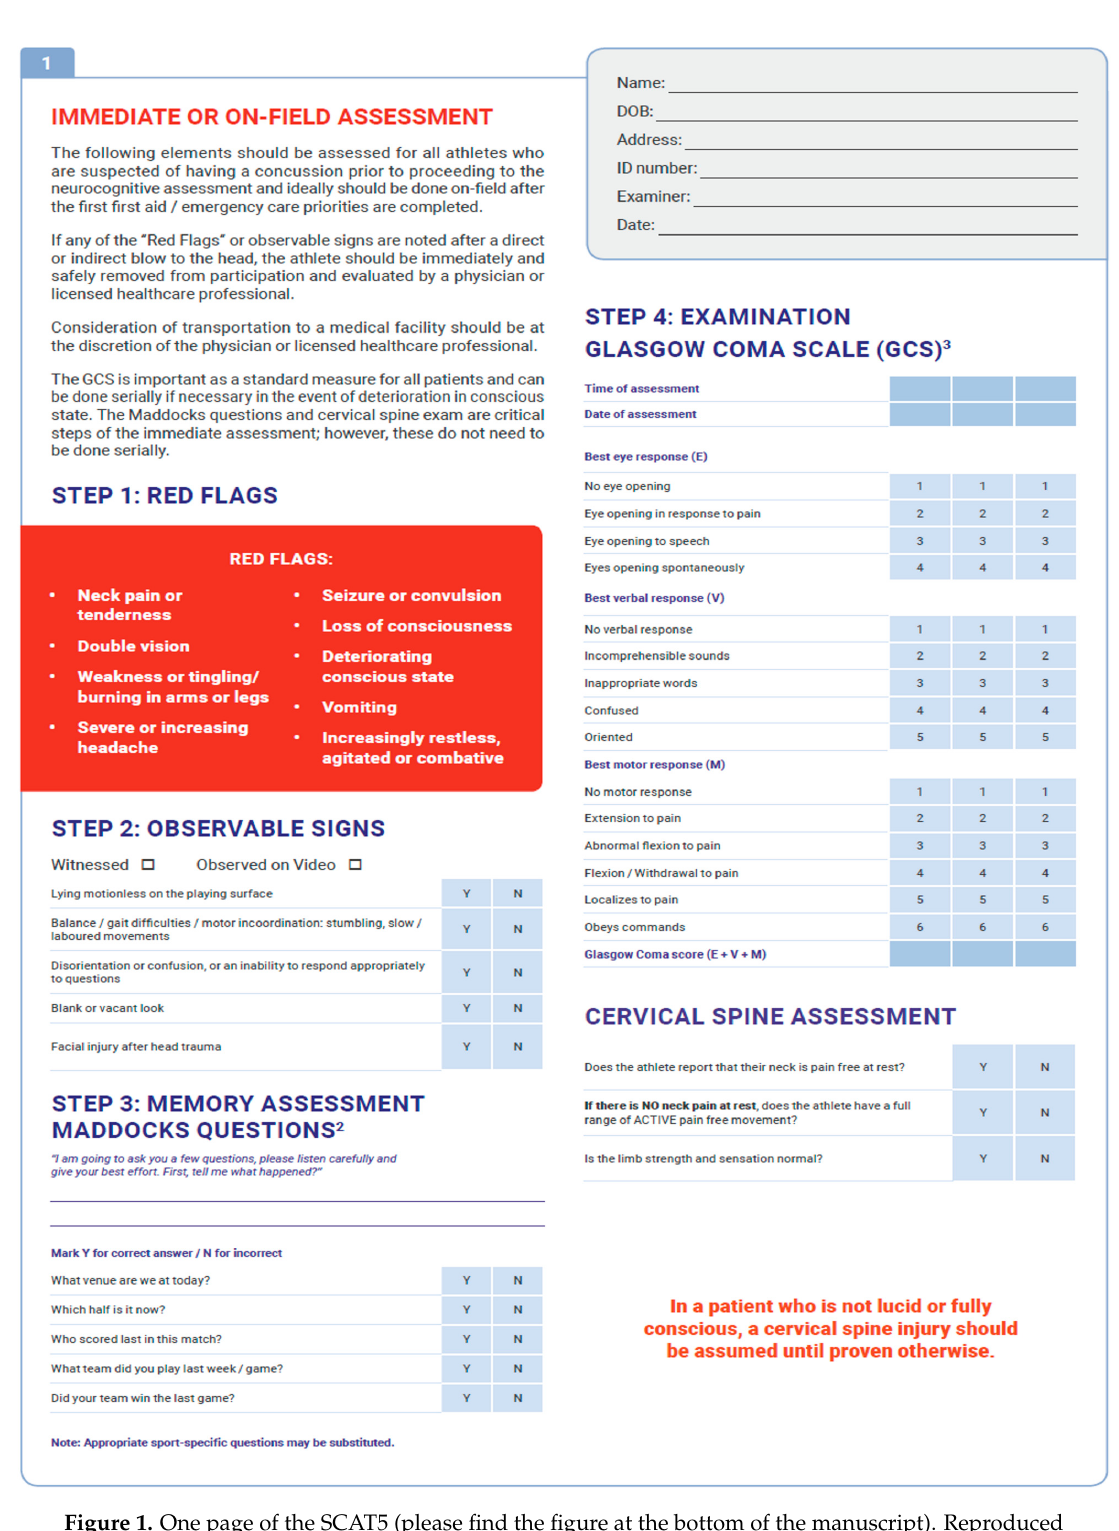
Figure 1. One page of the SCAT5 (please find the figure at the bottom of the manuscript). Reproduced from sport concussion assessment tool—5th edition, Echemendia R.J. et al., with permission from BMJ Publishing Group Ltd. doi.org/10.1136/bjsports-2017-097506SCAT5 [120].